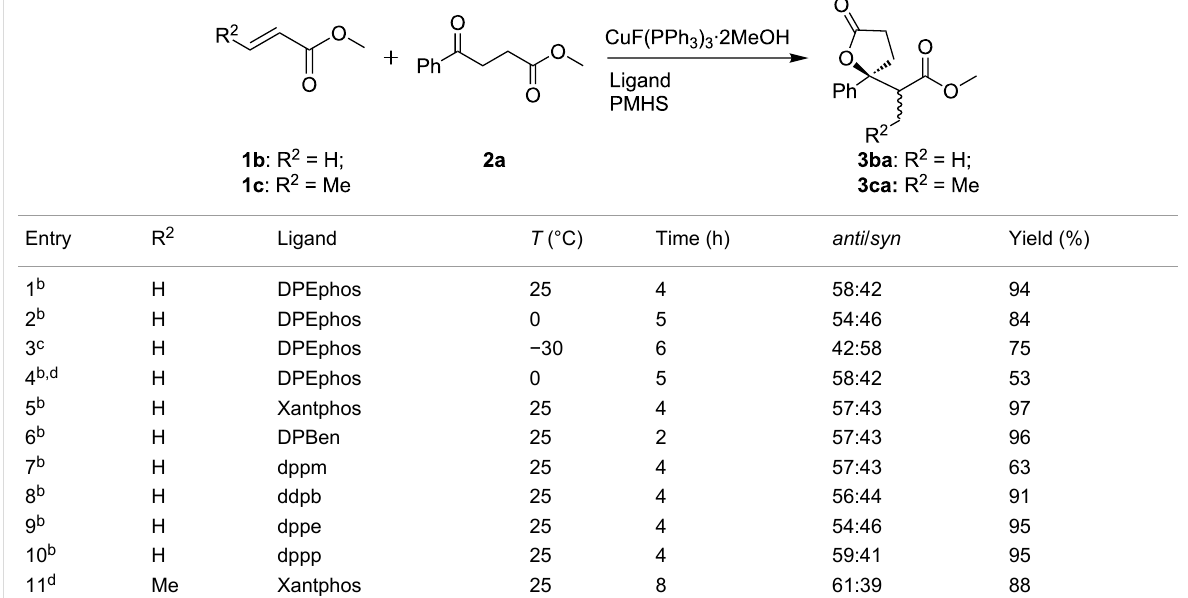
Table 2: Reaction of methyl 4-oxo-4-phenylbutanoate with methyl acrylate or methyl crotonate using different ligands a